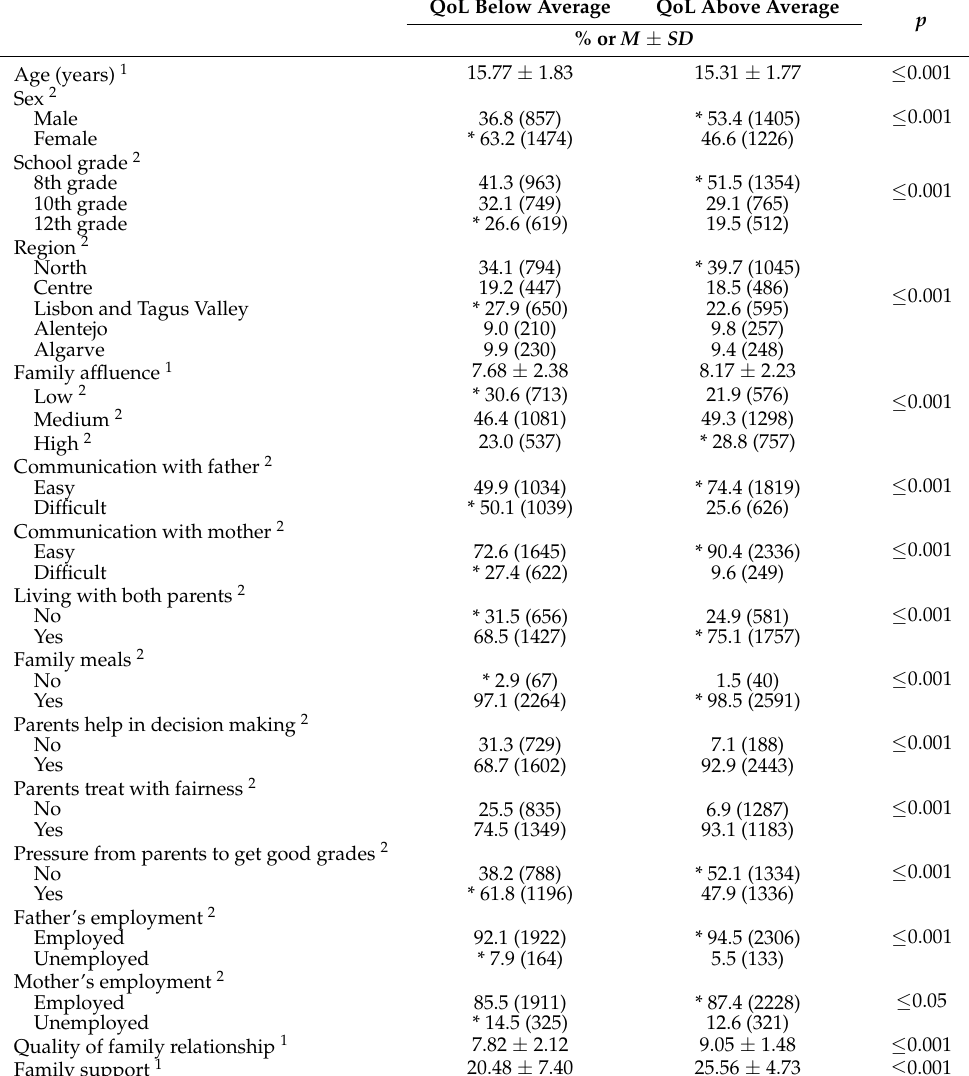
Table 3. Bivariate analysis between adolescents’ quality of life (QoL) and family